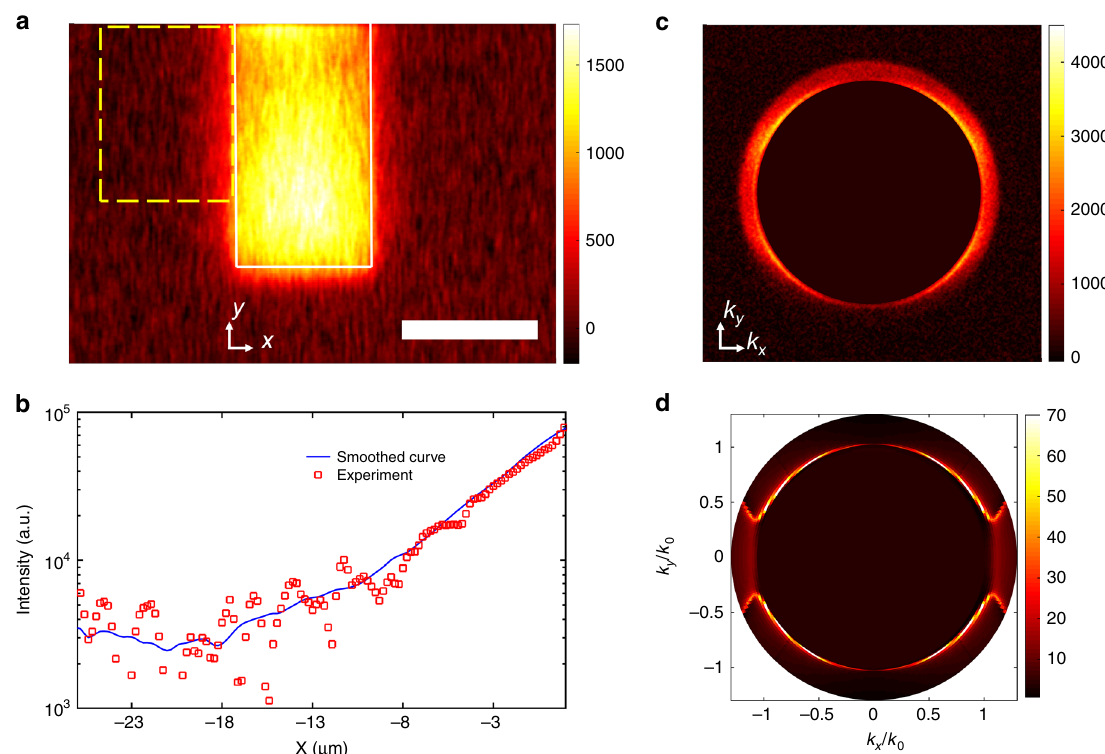
Fig. 3 Plasmon emission. a Image of the source plane showing the electrical excitation of SPP (under a biased voltage of 1.6 V). The white rectangle indicates the area of the array of antennas (the scale bar is 25 μ m). b Cross-section pro fi le along the x -axis in a semi-log plot is averaged over the y -axis in the yellow dashed line rectangle (red dots are experiment data, the blue smoothed curve is a guide to the eye to see the SPP pro fi le, the propagation length of the SPP is 4.9 ± 0. 3 μ m. c Experimental back focal plane image, showing the plasmon emission between k / k 0 = 1.0 (light cone in air) and k / k 0 = 1.3 (immersion objective numerical aperture), where k 0 = ω / c and k 2 = k x 2 + k y 2 , k x = n k 0 sin θ cos ϕ , where n = 1.5 is the refractive index of the substrate. d Simulated back focal plane image (at wavelength of 850 nm and the width of patch is 132 nm)